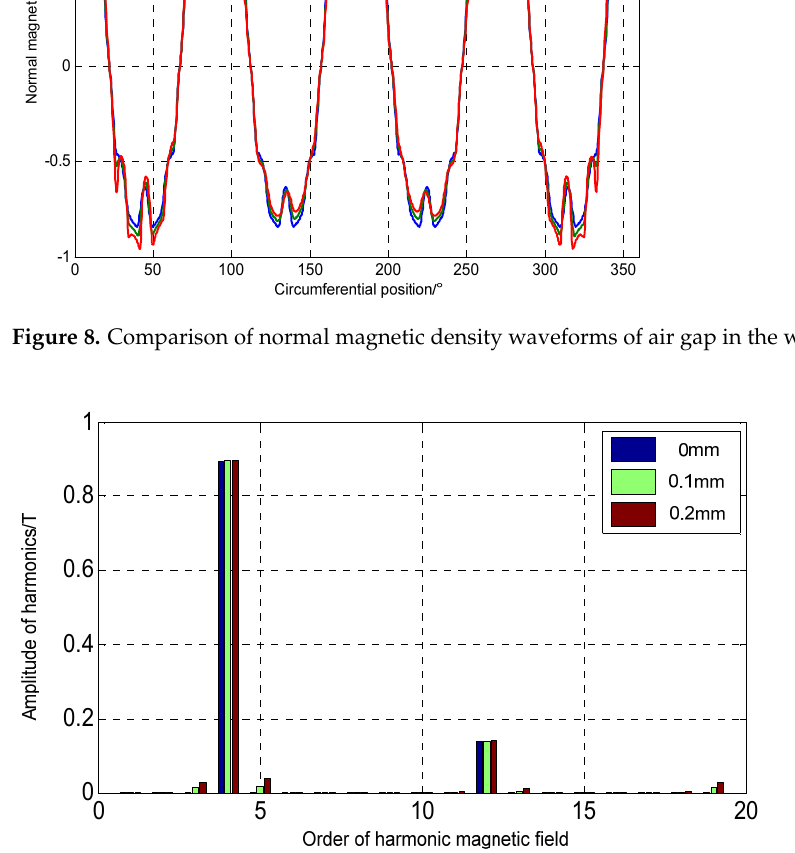
Figure 8. Comparison of normal magnetic density waveforms of air gap in the whole circumference.